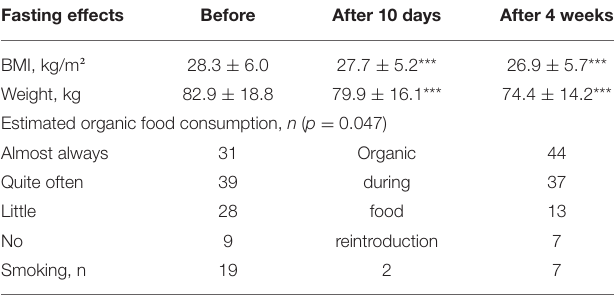
TABLE 1 | Baseline characteristics of the study population as well as weight changes, organic food consumption and smoking habits after fasting.